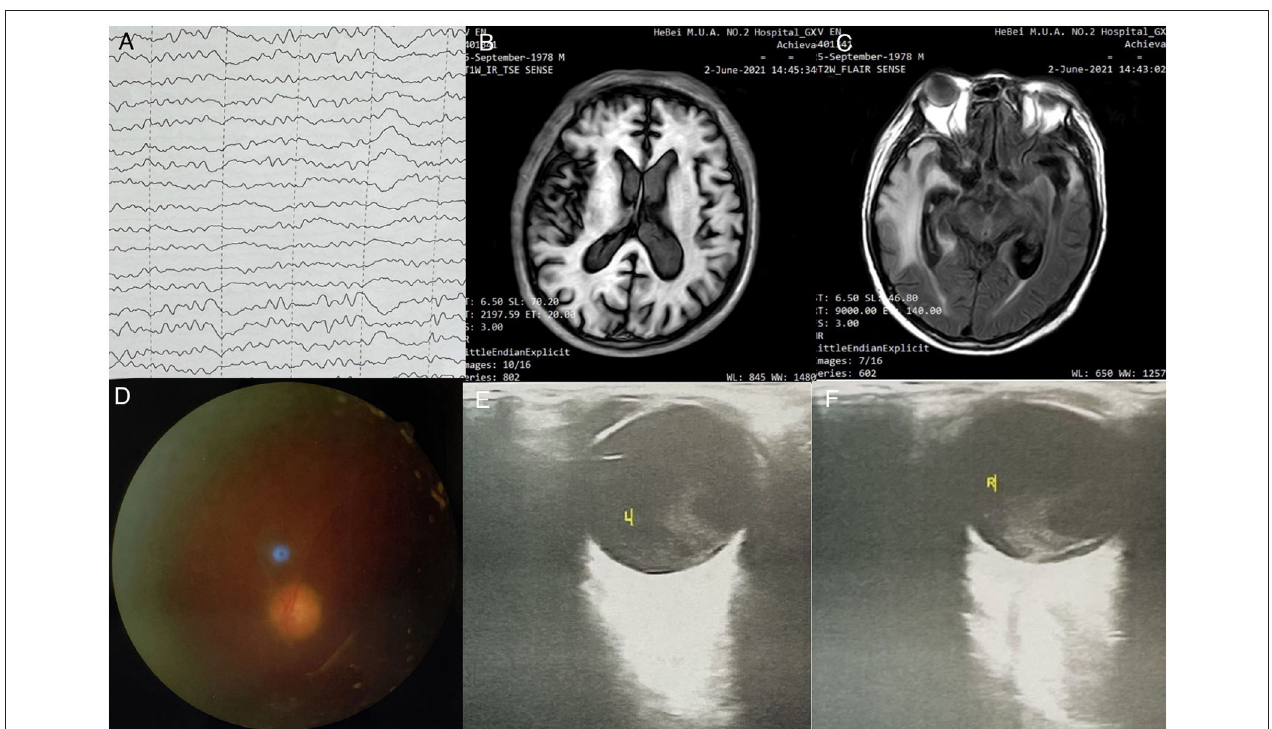
FIGURE 3 | (A) EEG examination: moderate to severe abnormal EEG, background diffuse 0, 6 slow wave bursts, 7-8Hz slow rhythm bursts in the occipital lobe; (B) Head MRI - T1IR-TSE: normal head size, bilateral frontal lobe, temporal lobe, insula, bilateral hippocampus, bilateral thalamus, bilateral cingulate gyrus, flaky T1 low signal; (C) Head MRI - T2 FLAIR sequence: head size is normal; temporal lobe, insula, and bilateral hippocampus present high signal in T2 FLAIR, high signal in FLAIR; local sulci are clearer than before; (D) Fundus examination-left eye; (E) Ophthalmic ultrasound-L: severe vitreous opacity, mild thickening of the posterior wall of the eyes; (F) Ophthalmic ultrasound-L: severe vitreous opacity, mild thickening of the posterior wall of the eyes, thickening of the inner rectus muscle of the right